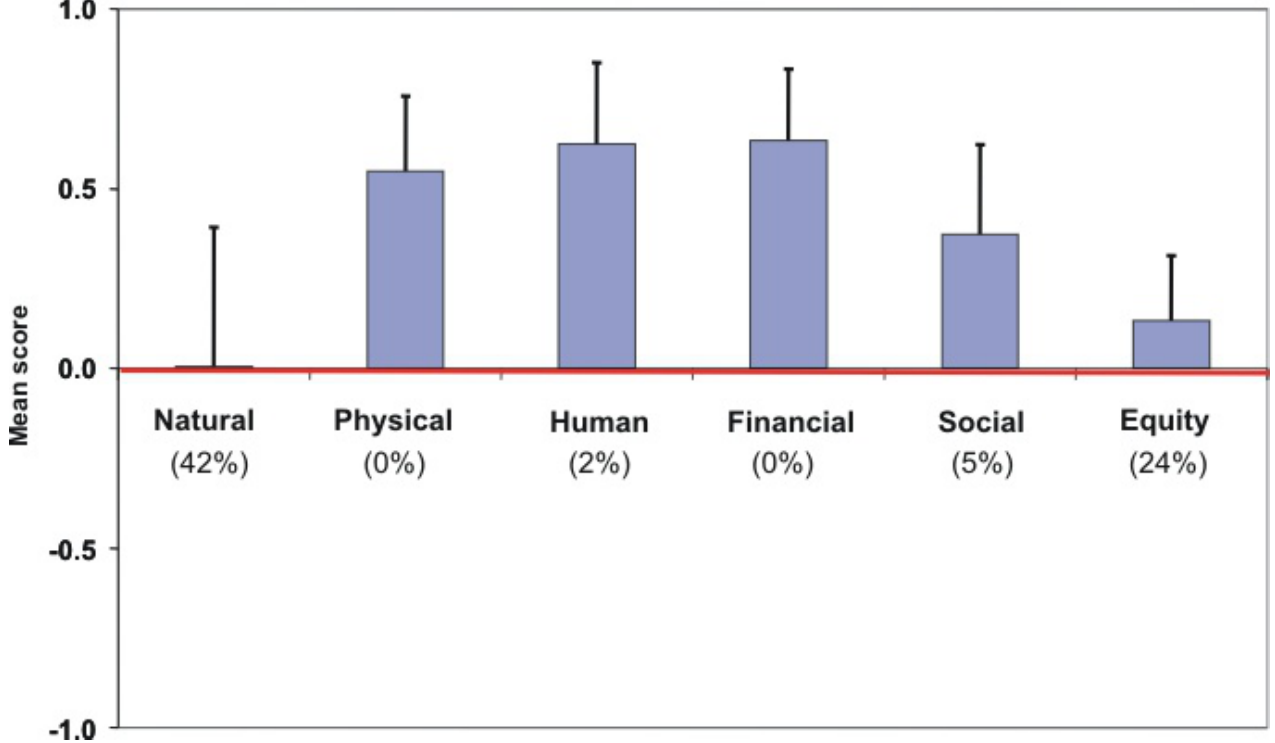
Fig. 1. Aggregated mean outcomes of the different livelihood components. The bars represent the mean and the lines represent the standard deviation. The percentage of cases with a negative mean score is presented in